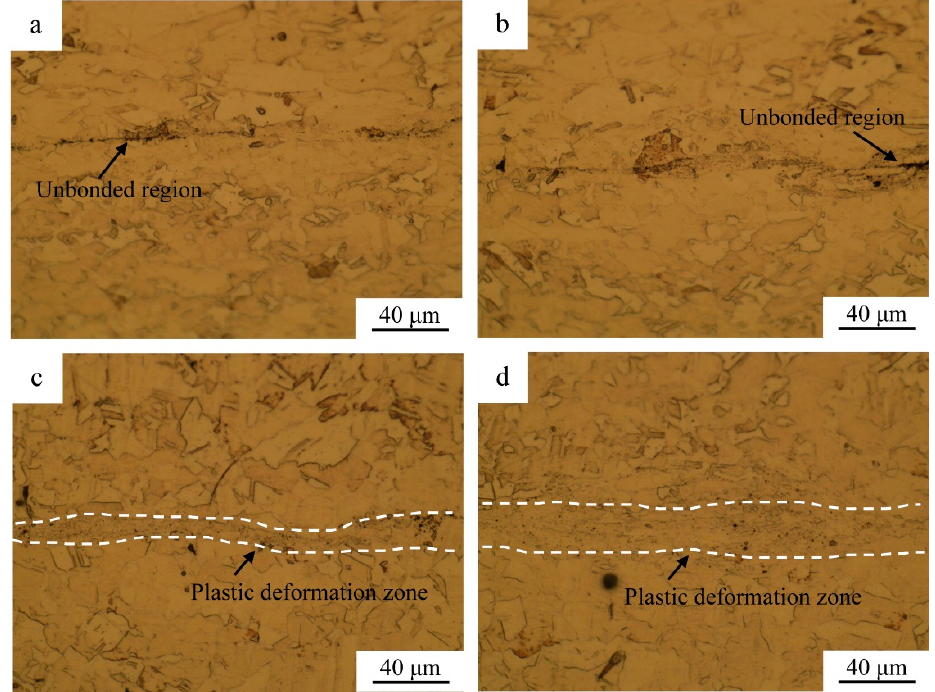
Figure 6. Optical micrographs of the welding interface for the joints without (( a )—0.45 MPa, ( c )—0.55 MPa) and with alcohol (( b )—0.45 MPa, ( d )—0.55 MPa).